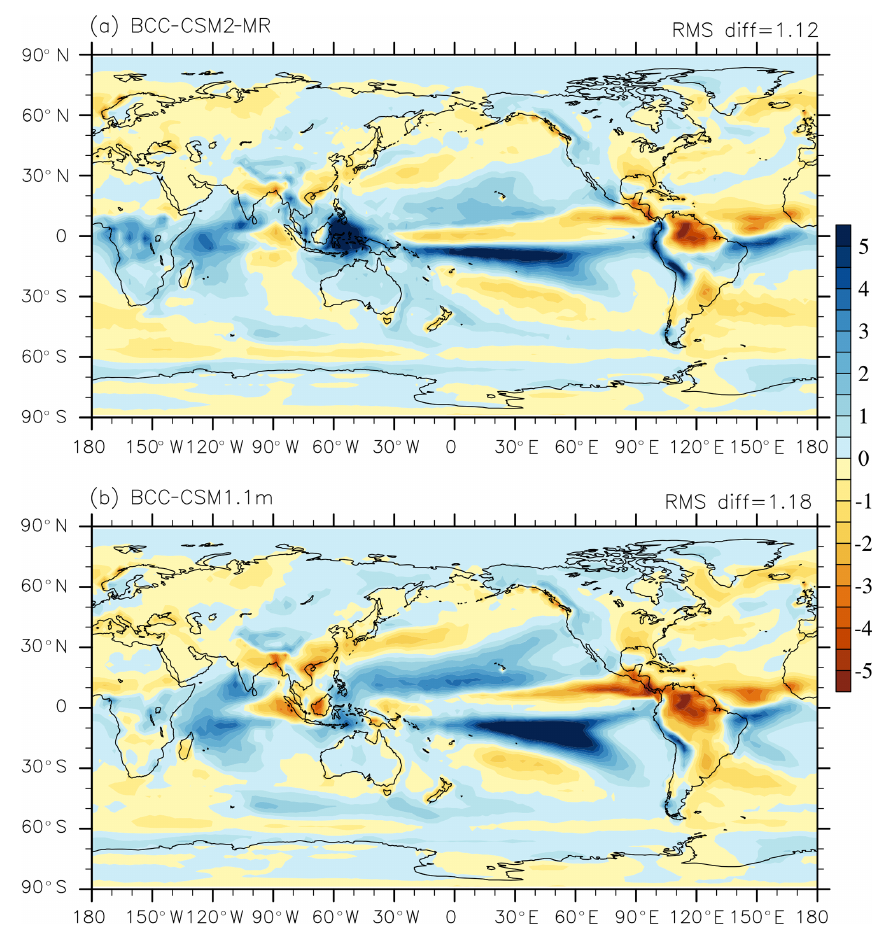
Figure 7. Annual-mean precipitation rate biases (mmd − 1 ) of (a) BCC-CSM2-MR and (b) BCC-CSM1.1m simulations in contrast with the 1986–2005 precipitation analyses from the Global Precipitation Climatology Project (Adler and Chang,